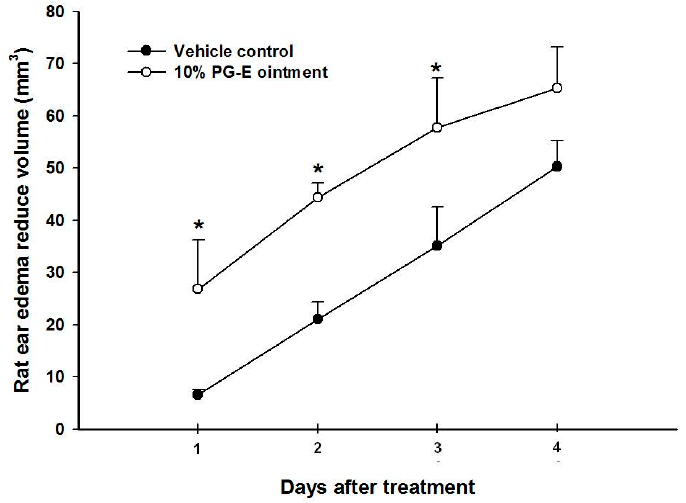
Figure 1. Anti-ear edema effects of pomegranate extract (PG-E) ointment against a P . acnes injection; * p < 0.05, compared to the vehicle group on the same day; Data are presented as the mean ± SD; Significance was calculated using Student’s t -test by SPSS software v.15; Each group contained eight rats.